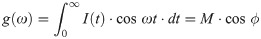
Comparative interaction study of elisidepsin and the plasma membrane of HCT-116 and HCT-116-Irv cells.
Untreated HCT-116 cells: Autofluorescence intensity image (A), FLIM-phasor image (B) and the corresponding phasor plot (C) of representative untreated HCT-116 cells. Grey mask on the FLIM-phasor image, and grey circles on phasor plot correspond to autofluorescence phasors. HCT-116-Irv cells treated with 5μM total elisidepsin (FRET donor: Irv-OG488 200 nM, FRET acceptor: Irv-A555 800 nM, elisidepsin 3 μM, 1:4:15): Fluorescence intensity image (D), FLIM-phasor image (E), and the corresponding phasor plot (F) of representative elisidepsin treated HCT-116-Irv cells. Green mask on FLIM-phasor image and green circles on phasor plot correspond to FRET donor (Irv-OG488) molecular species outside the cell where donor and acceptor molecules are at distances longer than 70 Å. For these species, the lifetime of Irv-OG488 in the media is not affected by the presence of Irv-A555 molecules, and it was assigned to the donor-only (τ
D, donor unquenched) phasor in the phasor plot for FLIM-FRET-phasor analysis. The lifetimes inside the cells have not changed substantially with respect to untreated cells, showing the typical autofluorescence behavior (grey mask and cursor). Elisidepsin molecules were not detected inside HCT-116-Irv treated cells. HCT-116 cells treated with 4μM total elisidepsin (FRET donor: Irv-OG488 200 nM, FRET acceptor: Irv-A555 800 nM, elisidepsin 3 μM, 1:4:15): Fluorescence intensity image (G), FLIM-phasor image (H), and the corresponding phasor plot (I) of representative elisidepsin treated HCT-116 cells. Green mask on FLIM-phasor image and green circles on phasor plot correspond to Irv-OG488 molecular species inside the cell that are not complexed with other elisidepsin molecules, so do not change their lifetime (donor unquenched lifetime). Pink mask and pink cursor correspond to elisidepsin complexes, containing elisidepsin, Irv-OG488 and Irv-A555 molecules at distances shorter than 50 Å, mainly located in the plasma membrane of affected cells. The lifetime of the FRET donor (Irv-OG488) in these complexes (τ
DA) decreases due to FRET to neighboring FRET acceptor (Irv-A555) molecules, and their corresponding phasor fall in the quenching FRET trajectory. Excitation wavelength: 755 nm. Laser frequency (f): 80x106 s-1. Emission: FF01 520/35. Phasor plot: g and s axis represent the real and imaginary parts of the Fourier transform of the fluorescence impulse response I(t): g(ω) = ∫0∞I(t)·cosωt·dt = M·cosϕ; s(ω) = ∫0∞I(t)·sinωt·dt = M·sinϕ; ω = 2 π f; M and ϕ are respectively the modulus and the phase of the phasor.